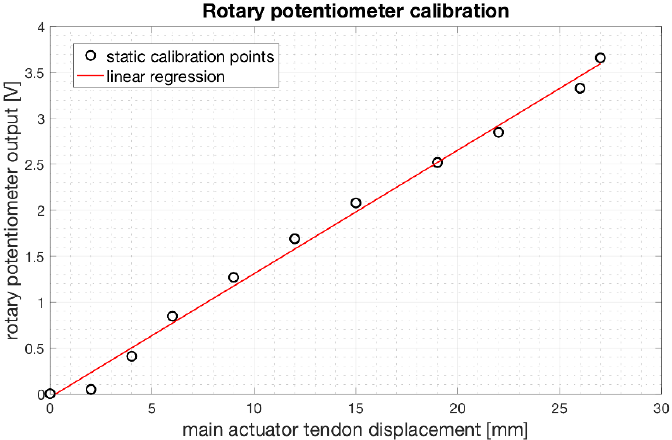
Figure 13. Relationship between the output voltages [V] from the rotary potentiometer fixed to the servomotor shaft as a function of the main actuator tendon displacement [mm]. Experimental data are plotted as black circles, while the linear regression function is plotted as a red continuous